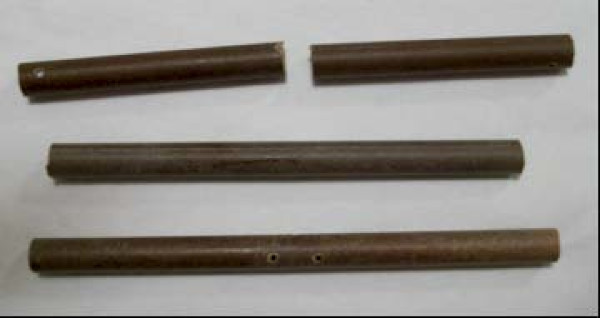
Tufnol tubes used.